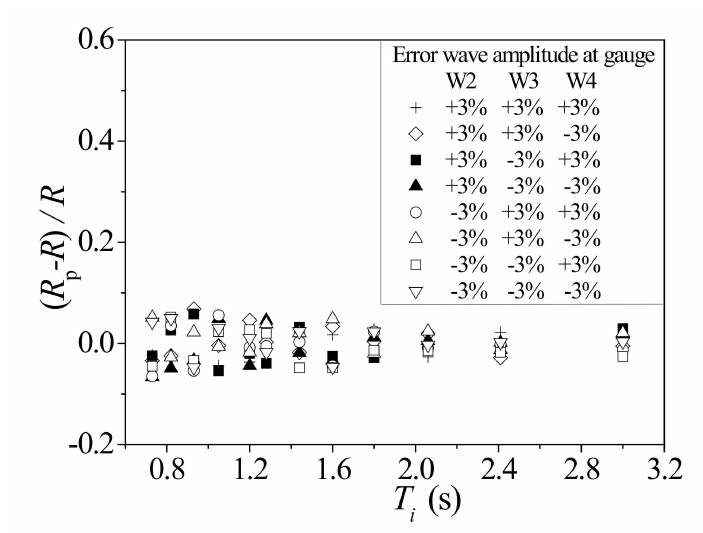
Figure 6. Estimated reflection coe ffi cient for eight conditions of over- or underestimated wave